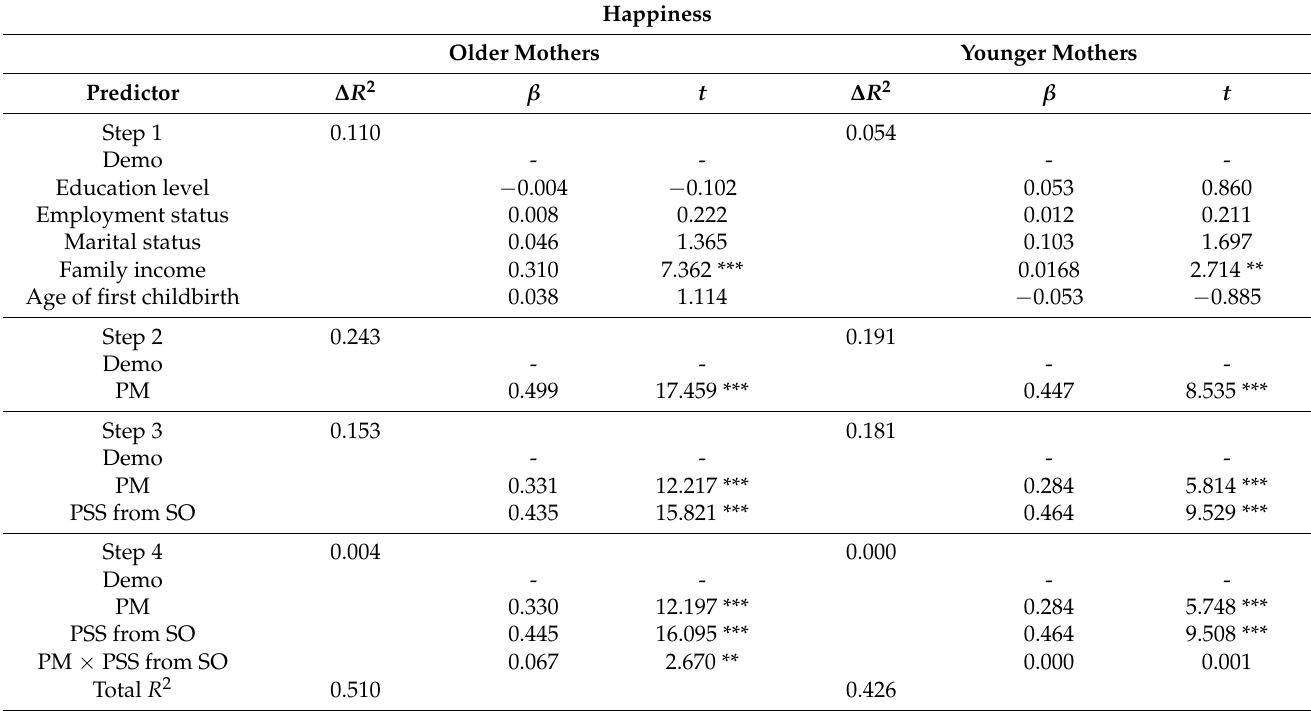
Table 7. Hierarchical regression analyses predicting happiness from presence of meaning in mother- hood and perceived social support from significant other among older ( n = 819) and younger mothers ( n = 295). Happiness Older Mothers Younger